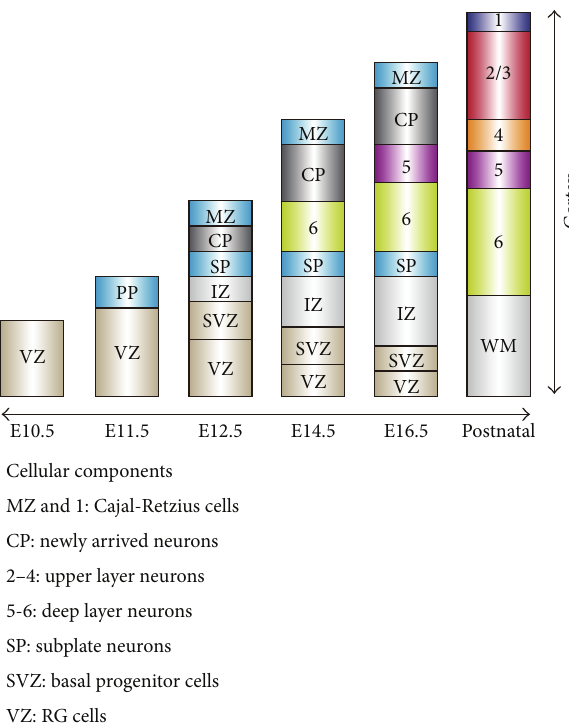
Figure 2: Neocortical development in the mouse. Preplate (PP) is composedoftheearliestbornneurons,whicharedifferentiatedfrom NSPCs in the VZ. PP is split into the subplate (SP) and marginal zone (MZ). NSPCs in the VZ also produce basal progenitor cells, resulting in the formation of the SVZ. The SP and MZ will form a part of layer 6 and the whole of layer 1 of the neocortex, respectively. Later, newborn neurons that form the cortical plate (CP) will form the multilayered neocortex in the postnatal brain, between layer 1 and layer 6. RG cells: radial glial cells, IZ: intermediate zone, and MW: white